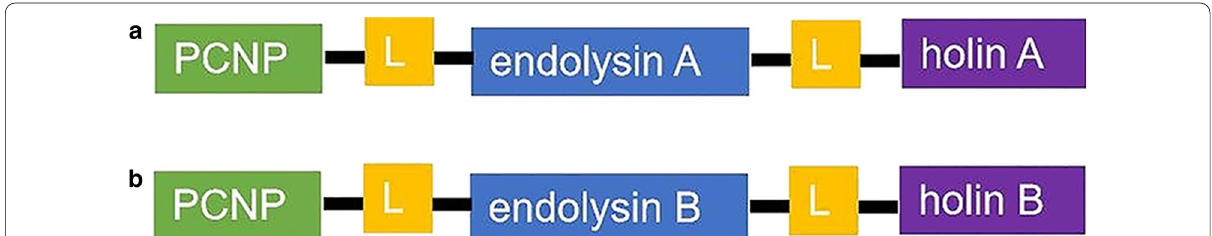
Fig. 1 Visual representation of engineered artilysins. Peptides with LPS-destabilizing activity were selected for modification with endolysins and holins identified in this study. Abbreviations: PCNP , polycationic nonapeptide; L, linker consisting of GAGA sequence. a The artilysin designed for use in the E. coli expression system BL21-pSUMO-artilysin1 is shown. b The artilysin designed for use in the E. coli expression system BL21-pSUMO-artilysin2 is shown